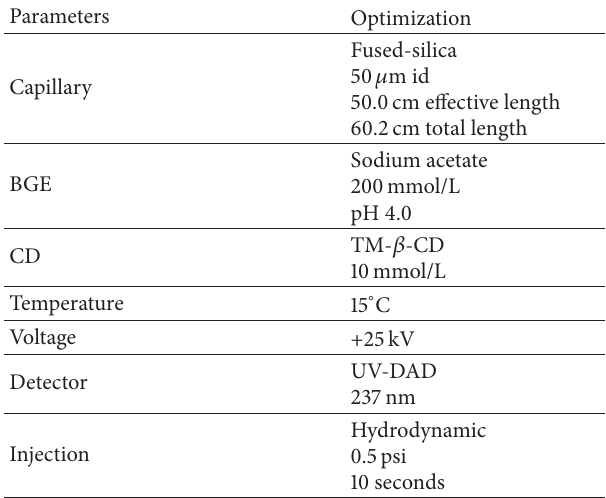
Table 3: Results of parameters optimization for LER enantiomers analyses.